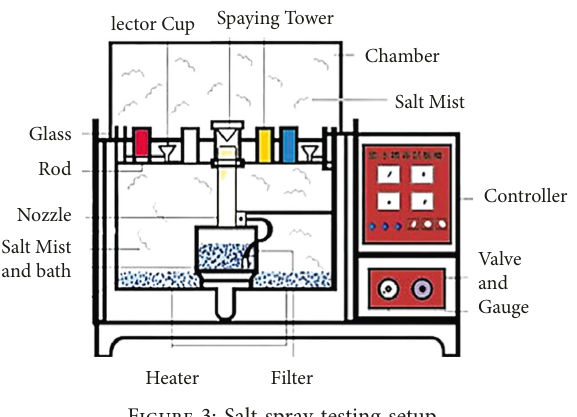
Figure 3: Salt spray testing setup.